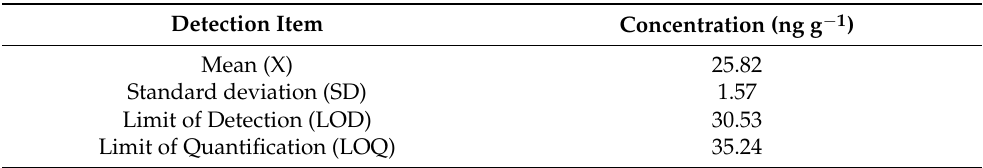
Table 3. The limit of detection and quantification of indirect competitive ELISA in food packaging materials ( n = 10).